Question: In one sentence, what is this figure communicating?
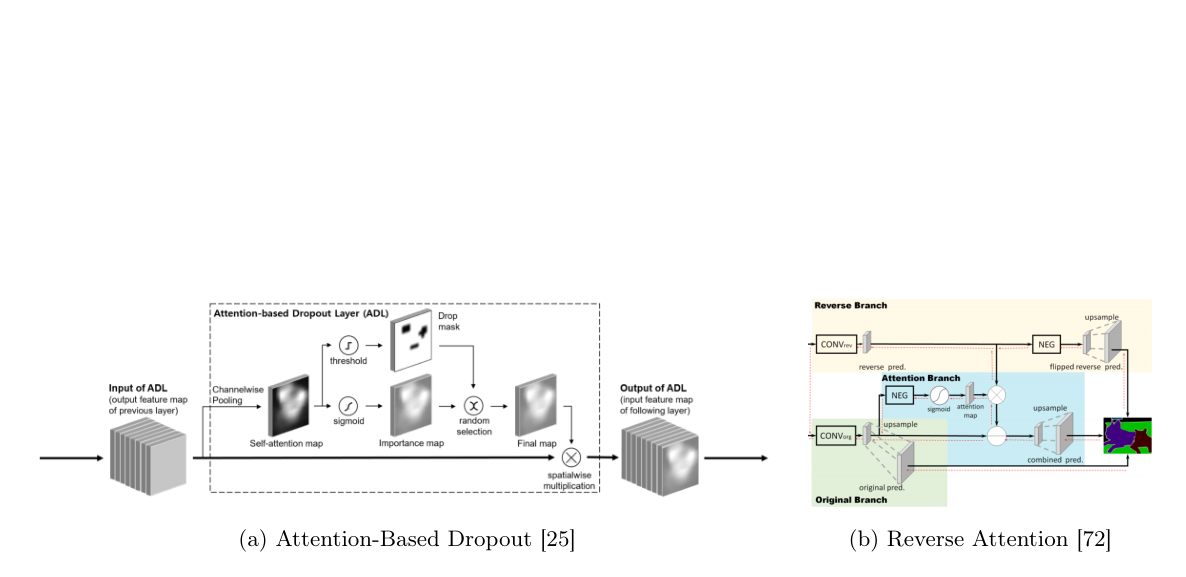
Answer: The arithmetic-based attention methods i.e. Attention-based Dropout [25] and Reverse Attention [72]. Images are taken from the original papers. These methods use arithmetic operations to generate the attention scores such as reverse, dropout or reciprocal.